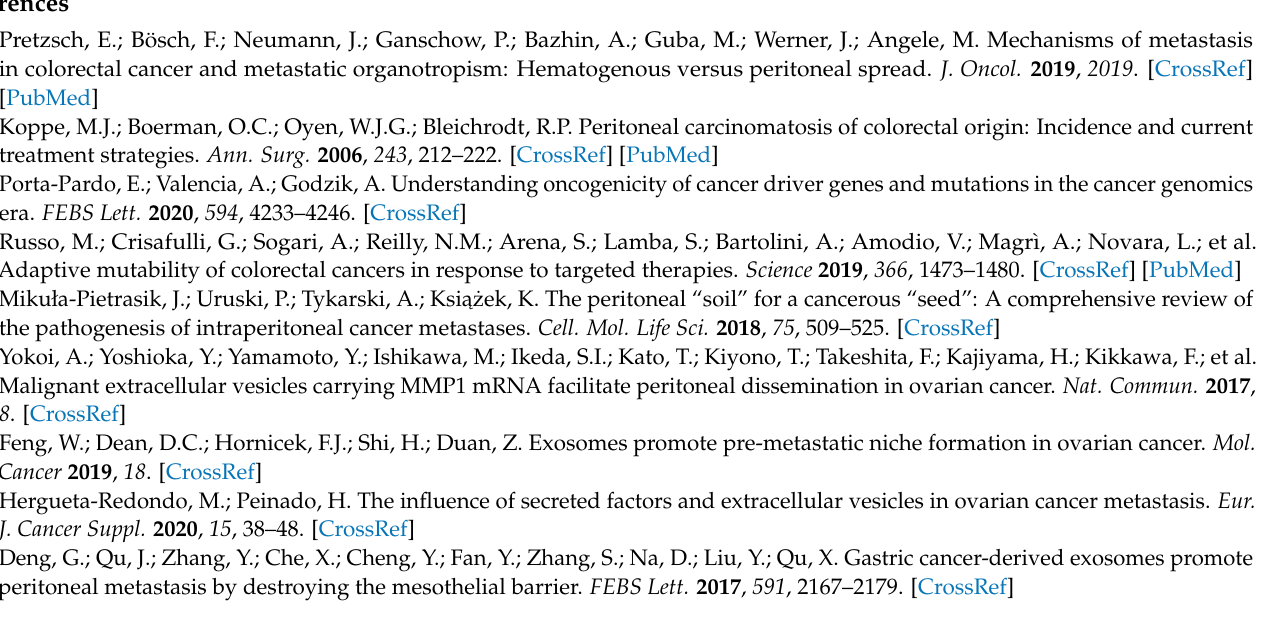
Figure S2: Whole blot related to Figure S1 and Figure 5c, Figure S3: Whole gel related to gelatin zymography assay, Figure S4: Establishment and characterization of primary cancer cell line PC1-V, Figure S5: PKH67-MC1 EVs are internalized in tumor cells and colocalize with lysosome marker LAMP-1, Figure S6: Whole blot related to Figures 2c and 4d, Figure S7: Internalization and character- ization of tumor-EVs, Figure S8: Modulation of MC1 invasiveness by CMs and EVs of PC1-V and dFB, Figure S9: PLF EVs pool reduces mesothelial cells motility, Table S1: Materials, Table S2: Ev isolation characteristics, Table S3: Intensity ratio of Western Blot images showing in Figures 2c, 4d, 5c, and densitometry readings and showing in S1c, Table S4: Densitometry readings of the gelatine zymography bands showing in Figure